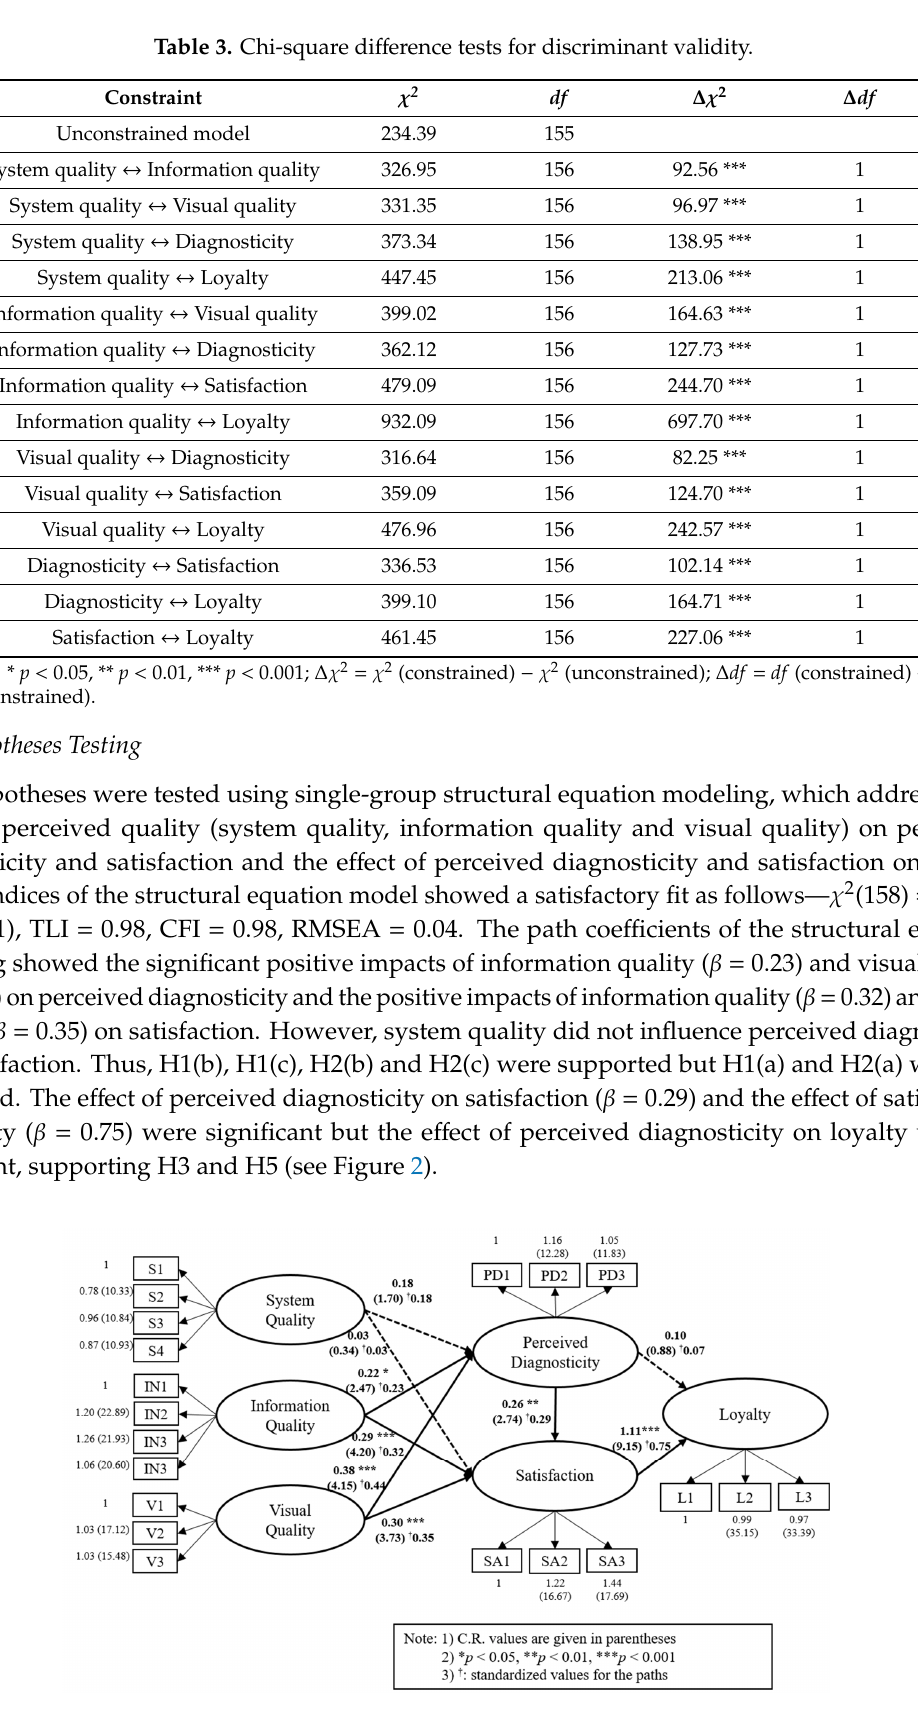
Figure 2. Findings for hypotheses 1 to 5 ( n = 283).